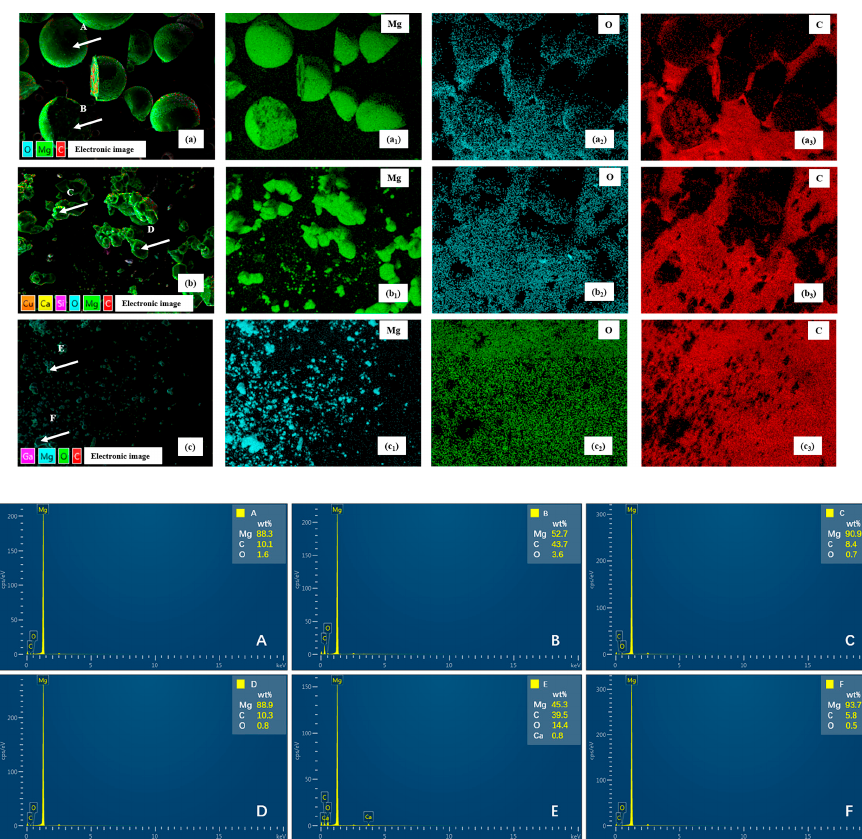
Figure 11. Mapping and EDS of Mg vapor condensation in different condensation zones (1473 K heating and 0.2 m 3 / h Ar): ( a ) Mapping of Mg product at 12.8–17 cm, ( b ) Mapping of Mg product at 17–22